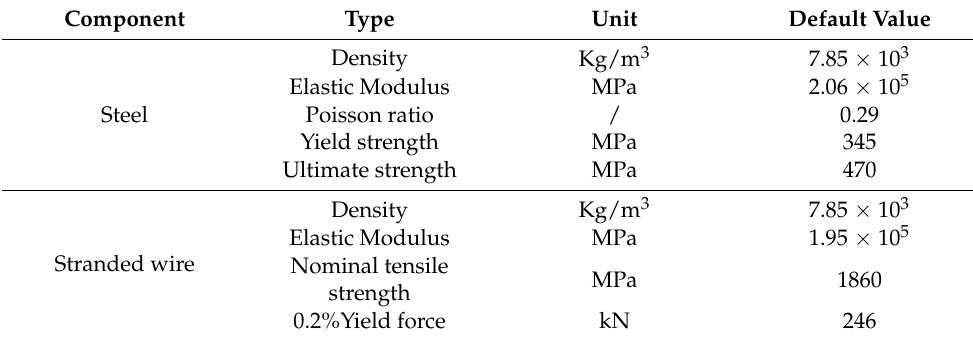
Table A4. Material properties used in the finite element guardrail